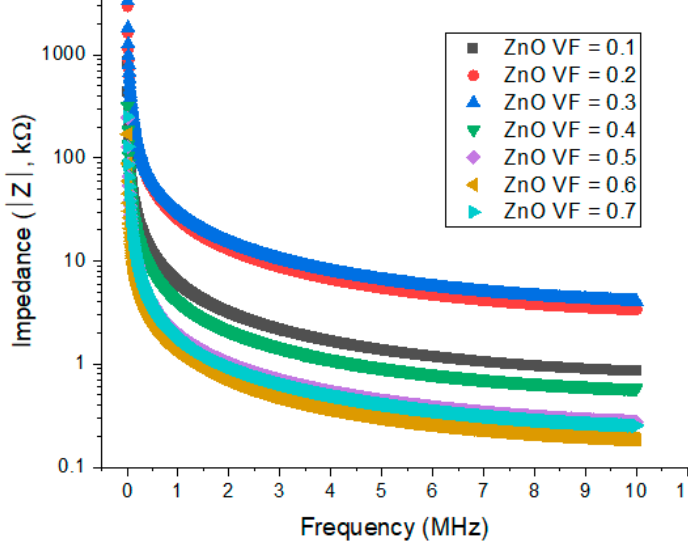
Figure 9. Variation of the Impedance spectrum for the nanocomposite samples for different volume fractions of ZnO with a change of frequency from 20 Hz – 20 MHz.